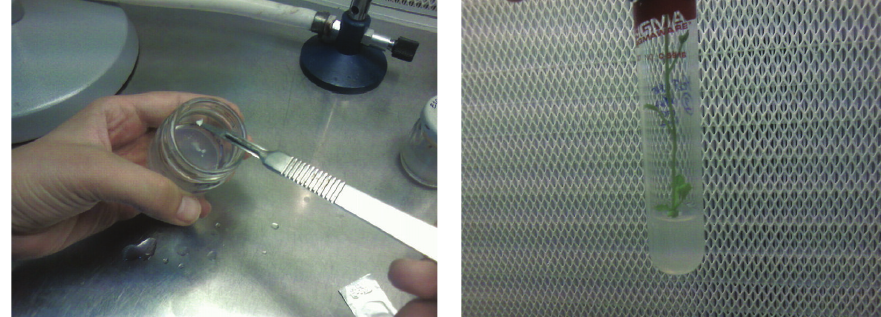
Figure 3: A haploid melon embryo and a plant obtained through germination of this embryo.